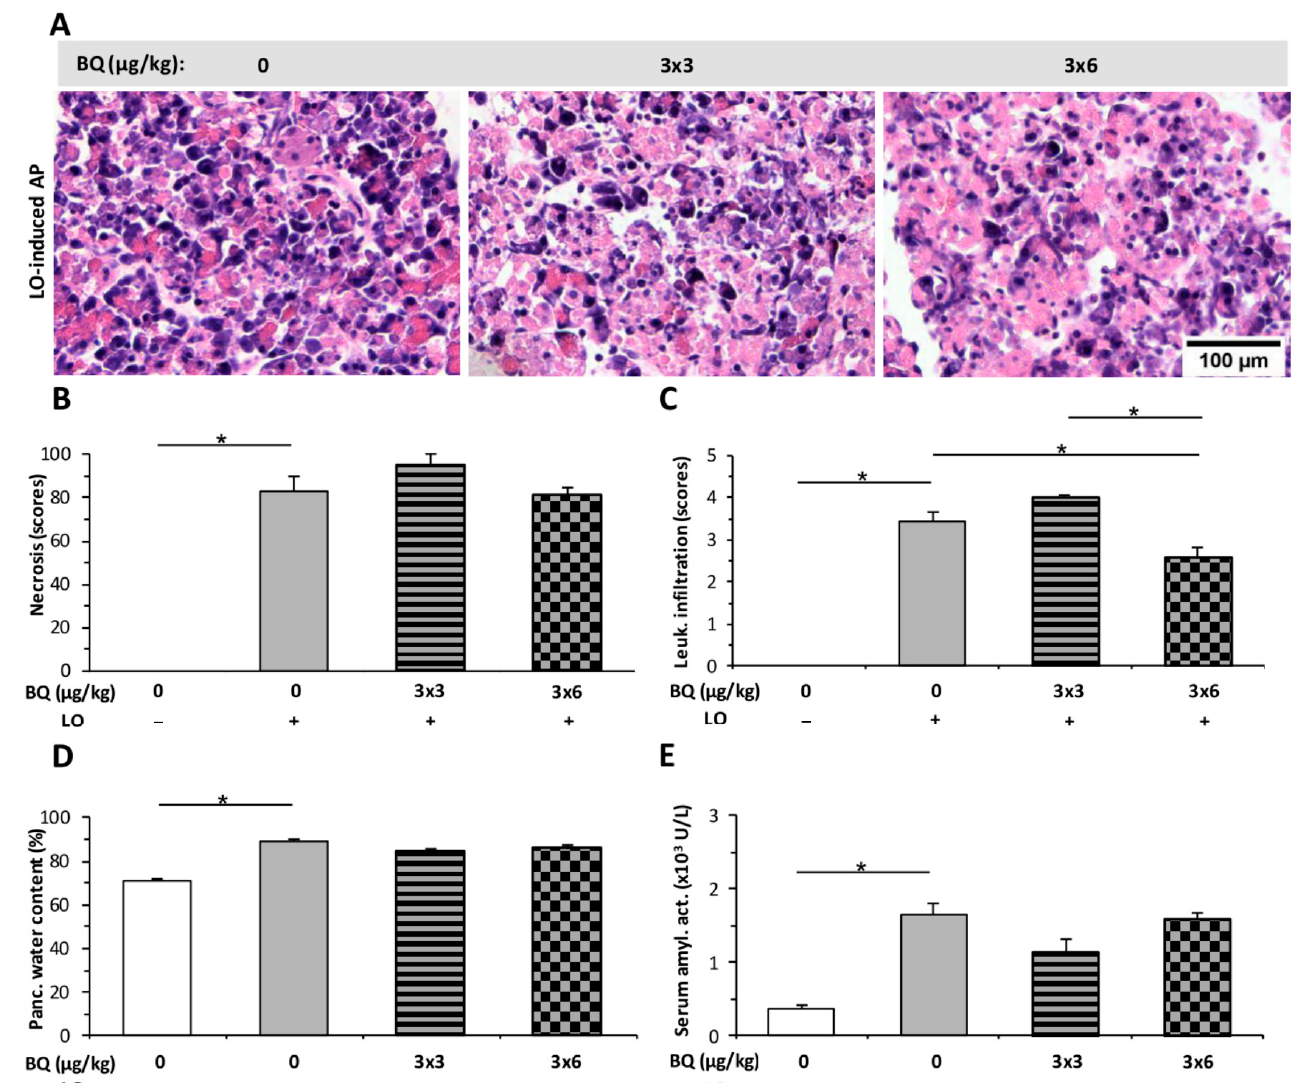
Figure 9. Intrathecal (i.t.) buprenorphine (BQ) treatment does not affect the severity of L-ornithine (LO)-induced acute pancreatitis (AP). Rats were treated with 3 × 3 or 3 × 6 mg/kg BQ i.t., whereas i.p. injection with 3 g/kg LO (LO +) was used to induce AP. Control animals received physiological saline instead of LO (LO − ) or BQ (0 mg/kg). Animals were sacrificed at 24 h after the first CER or physiological saline injection. ( A ) Representative histopathological images of pancreatic tissues of the treatment groups. Bar charts show the extent of pancreatic ( B ) necrosis, ( C ) leukocyte infiltration, ( D ) water content, and ( E ) serum amylase activity measurements. Values represent mean with standard error, n = 6. ANOVA was performed followed by the Holm–Sidak post hoc test. * p < 0.05.